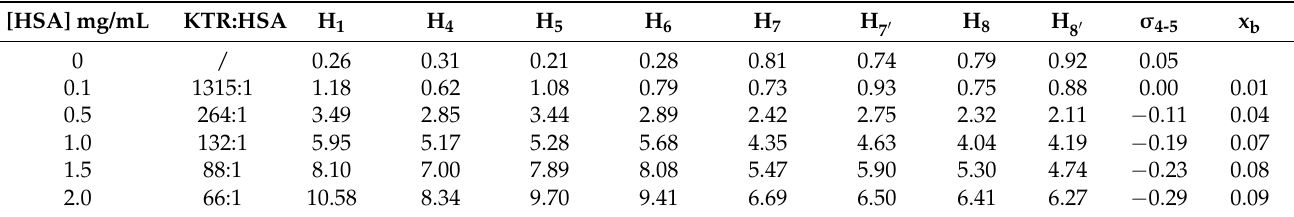
Table 1. 1 H mono-selective relaxation rates R 1ms (s − 1 ) (600 MHz, 25 ◦ C, D 2 O, pH = 7.4) of some protons of KTR (2 mM) in its free state; normalized mono-selective relaxation rates ( ∆ R 1ms /R f , ∆ R 1ms = R obs − R f ) of KTR protons in mixtures with HSA at different molar ratios; cross-relaxation rate ( σ ij